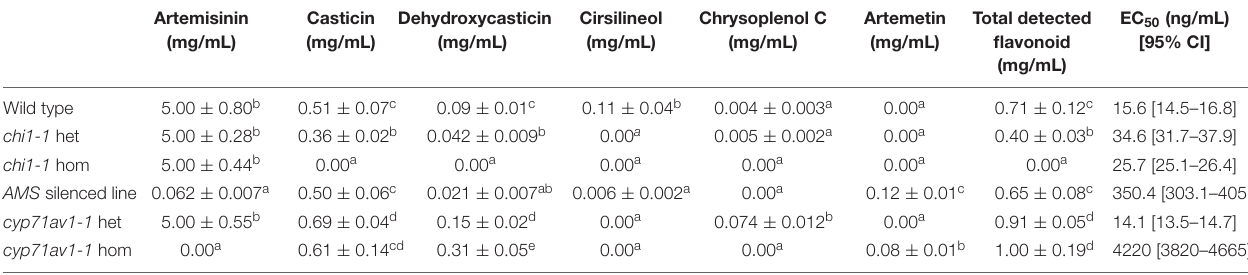
TABLE 1 | Artemisinin and flavonoid levels and antimalarial efficacy of plant extracts.